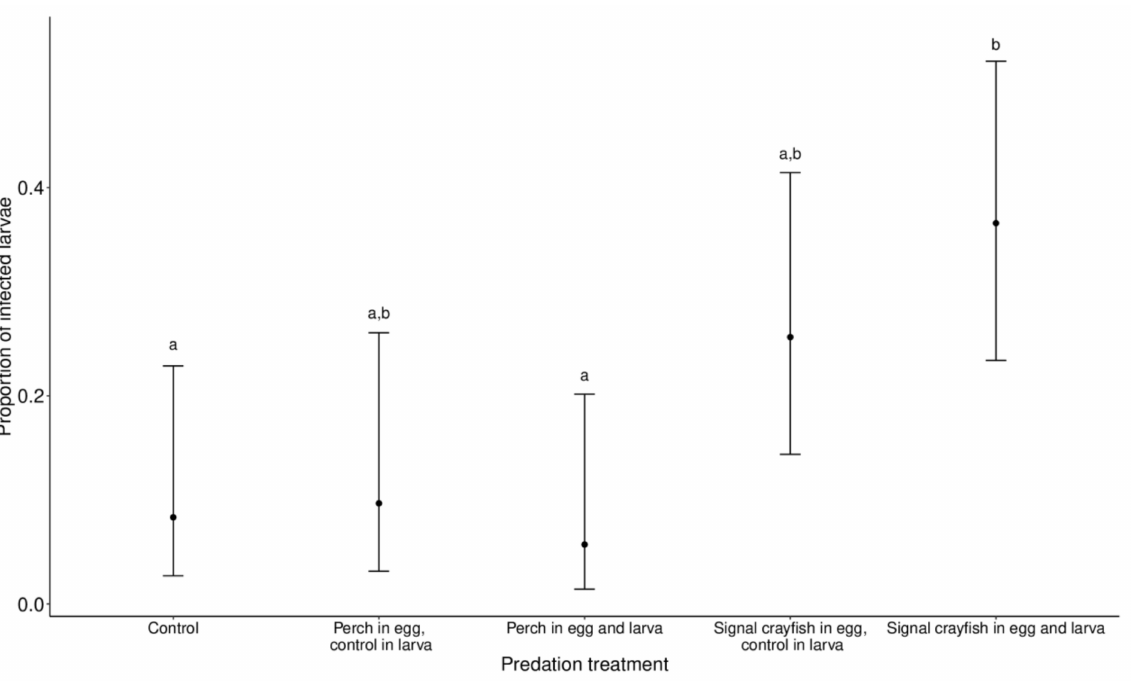
Figure 2. The proportion of microsporidian infections in I. elegans larvae in the different predator treatment groups. Ischnura elegans eggs and larvae were exposed to perch or signal crayfish cues either during egg or egg and larval stages. The control group was not exposed to predator cues during either stage. Data are displayed as the marginal means ± 95% CI. Different letters at the top of the error bars indicate significant differences between experimental